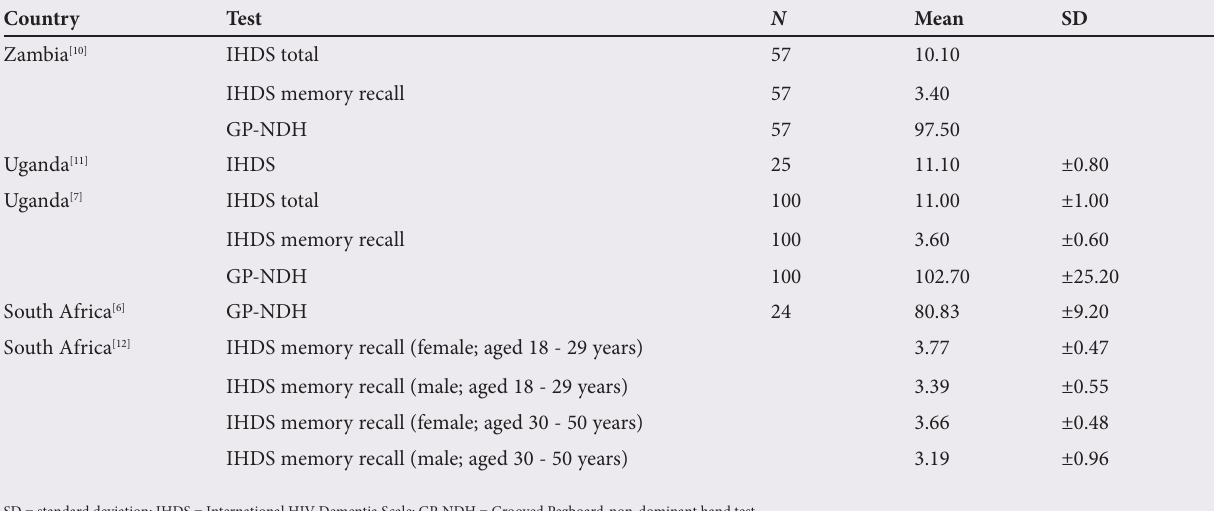
Table 1. Scores for IHDS and GP-NDH tests conducted among HIV-negative respondents in East and Southern Africa Country Test N Mean SD Zambia [10] IHDS total 57 10.10